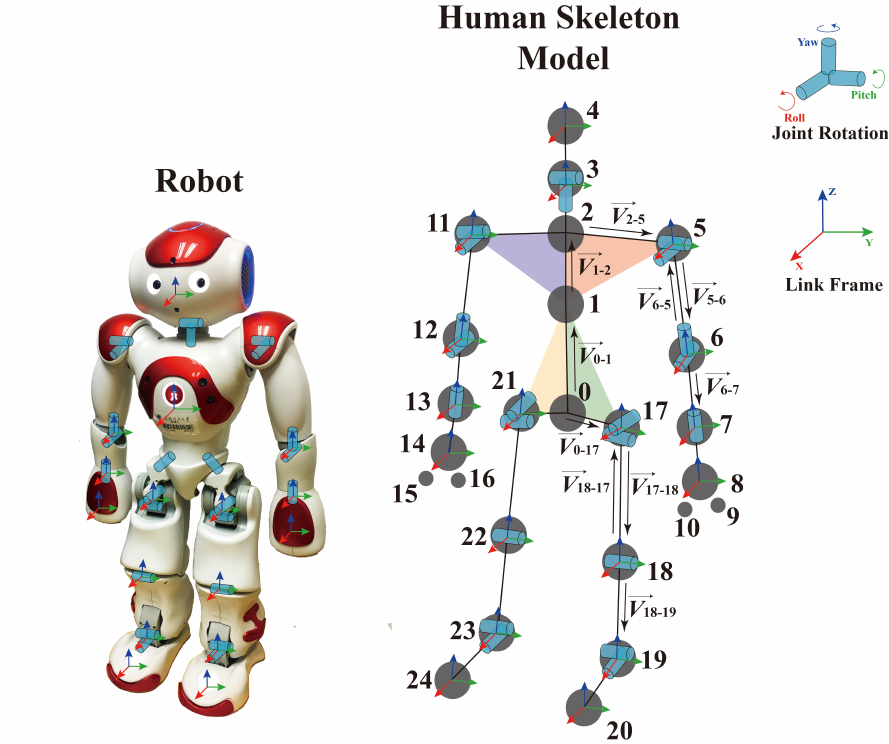
Figure 4. Joint structures and link frames of the robot and the human skeleton